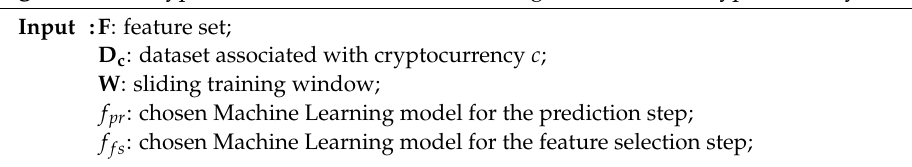
Algorithm 1: CryptoMLE: Procedure of dashboard generation for a